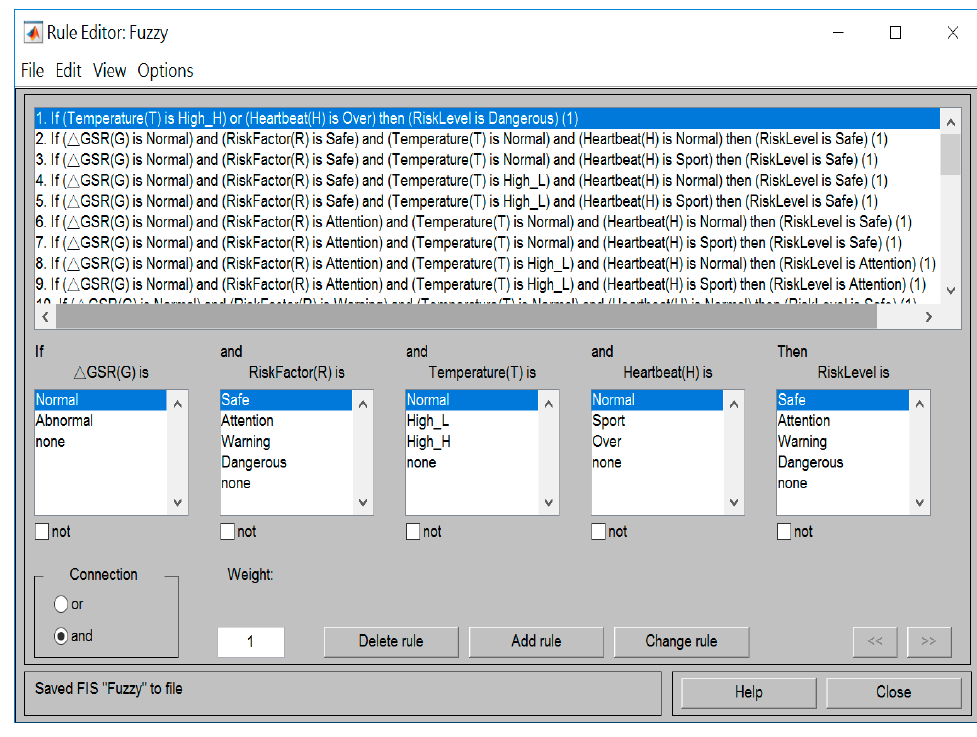
Figure 9. Fuzzy rule base.